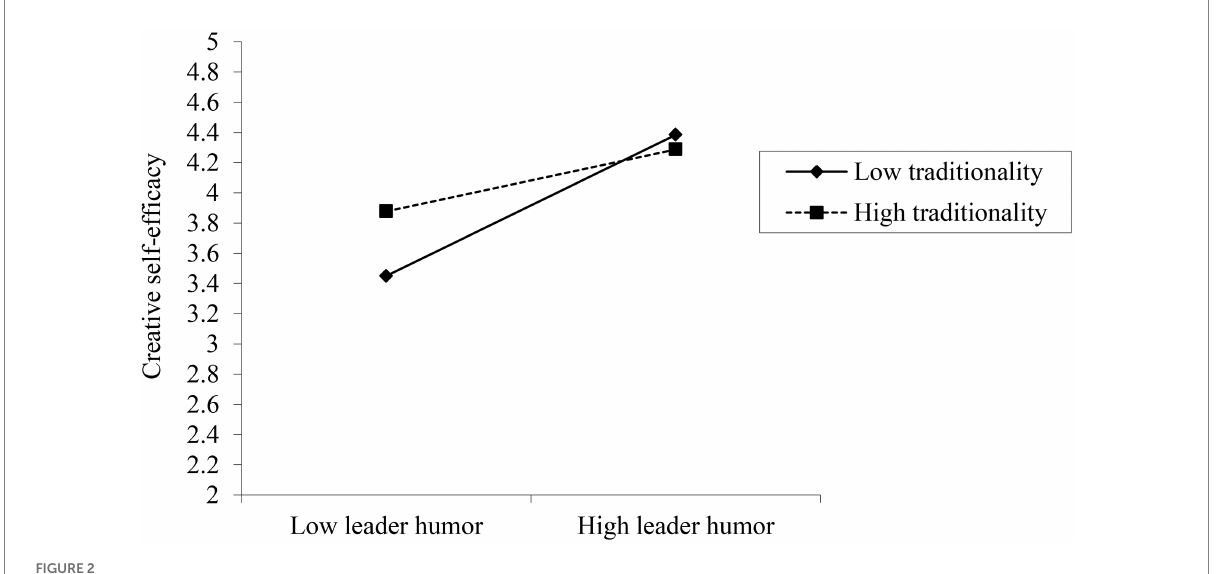
FIGURE 2 The moderating effect of traditionality.